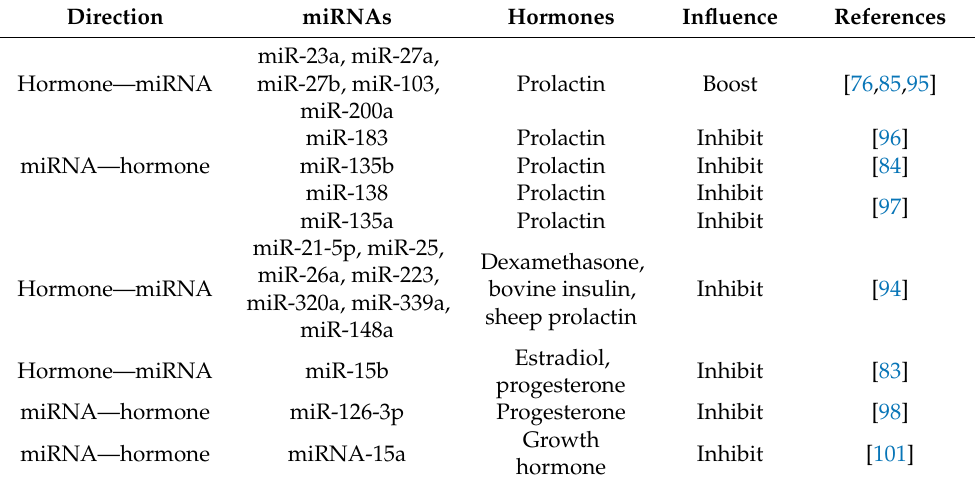
Table 5. A brief summary of the reciprocal regulation of miRNAs and various